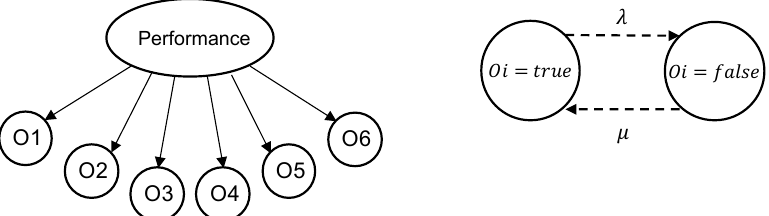
Figure 2. ( Left ) Qualitative specification of the Bayesian Network for Performance. ( Right ) The transition graph for